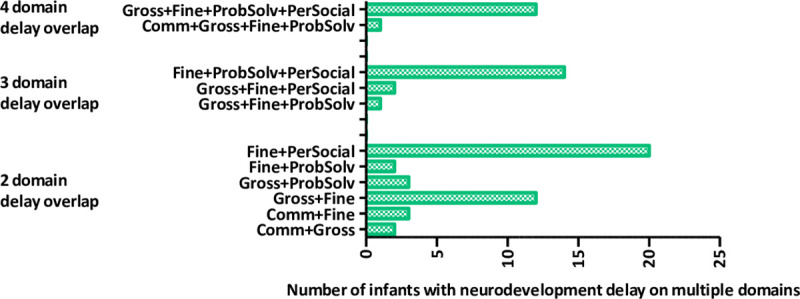
Distribution of delayed neurodevelopment on two, three and four overlapping domains.Neurodevelopment delay overlap on two domains: Fine+PerSocial: fine motor & personal social; Fine+ProbSolv: fine motor & problem solving; Gross+ProbSolv: gross motor & problem solving; Gross+Fine: gross & fine motor; Comm+Fine: communication & fine motor; Comm+Gross: communication & gross motor. Neurodevelopment delay overlap on three domains: Fine+ProbSolv+PerSocial: fine motor & problem solving & personal social; Gross+Fine+PerSocial: gross motor & fine motor & personal social; Gross+Fine+ProbSolv: gross motor & fine motor & problem solving. Neurodevelopment delay overlap on four domains: Gross+Fine+ProbSolv+PerSocial: gross motor & fine motor & problem solving & personal social; Comm+Gross+Fine+ProbSolv: communication & gross motor & fine motor & problem solving.